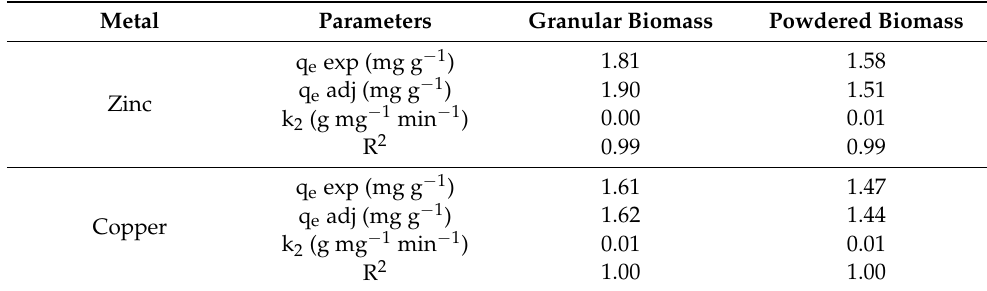
Table 3. Parameters of the pseudo-second-order kinetic